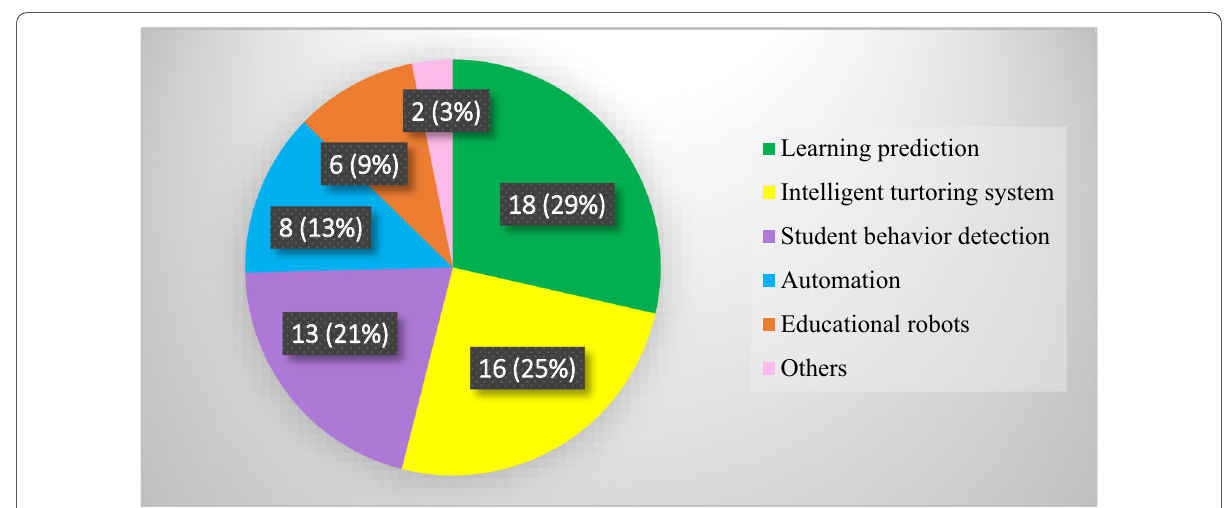
Fig. 5 The application categories of AI techniques in STEM education ( N